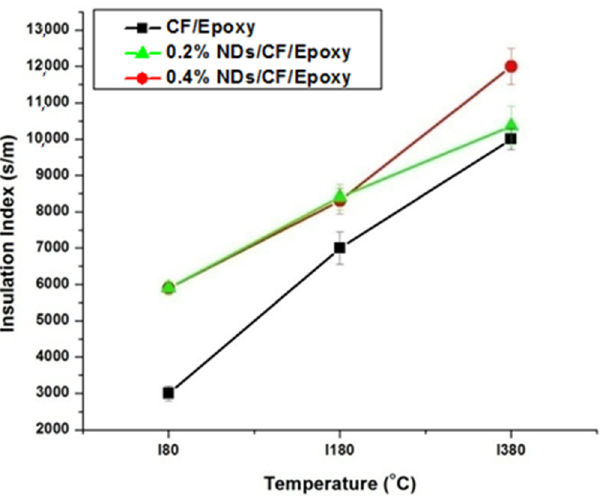
Figure 9. Percentage weight loss and erosion rate of CFRE-Cs with and without NDs. Specimen A represents CF/epoxy composite, specimen B represents CF/epoxy/0.2 wt% NDs composite, and specimen C represents CF/epoxy/0.4 wt% NDs composite.